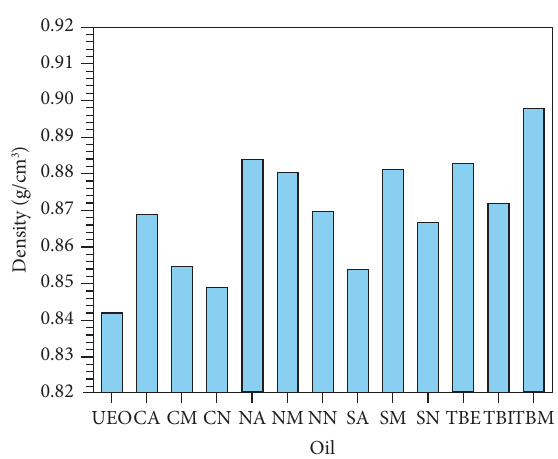
Figure 1: Densities of used engine oil and re-refned oils.